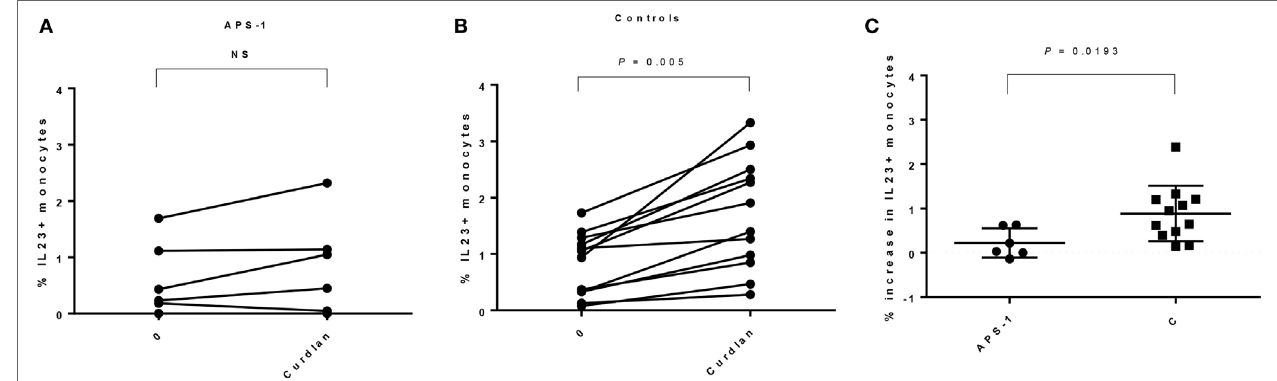
FigUre 3 | Interleukin (IL)-23p19 responses found in monocytes in autoimmune polyendocrine syndrome type 1 (APS-1) patients and controls. The figure gives an overview of the IL-23p19 response found in monocytes in patients versus controls. (a) APS-1 patients; no significant increase in IL-23p19 was detected in monocytes. Numbers at the Y -axis gives the percentages of IL-23p19 + monocytes after stimulation with curdlan. (b) Controls; a significant increase in IL-23p19 was detected in monocytes. The numbers at the Y -axis give the percentages of IL-23p19 + monocytes after stimulation with curdlan. (c) Comparing the increase in IL-23p19 + monocytes found in APS-1 and controls at baseline and after curdlan stimulation. NS, not